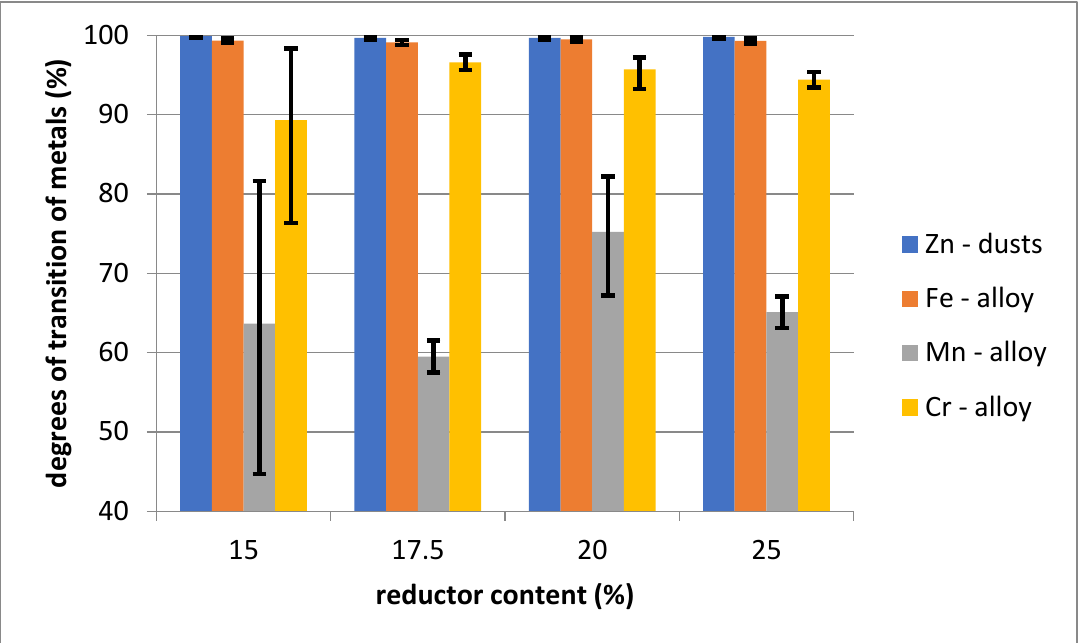
Figure 6. Dependence of the degrees of transition of metals to dust and alloy on the content of reductor. The slag obtained in smelting has a low content of zinc, lead and copper. The total content of these metals does not exceed 0.2%. The iron content is also low and, with one exception, does not exceed 1%. This indicates high recovery rates of zinc to dust and iron to alloy. This slag composition allows its use as an aggregate. ardous components. A leaching test was therefore carried out according to the TCLP (Toxicity Characteristic Leaching Procedure). Leaching was analysed by ICP OES